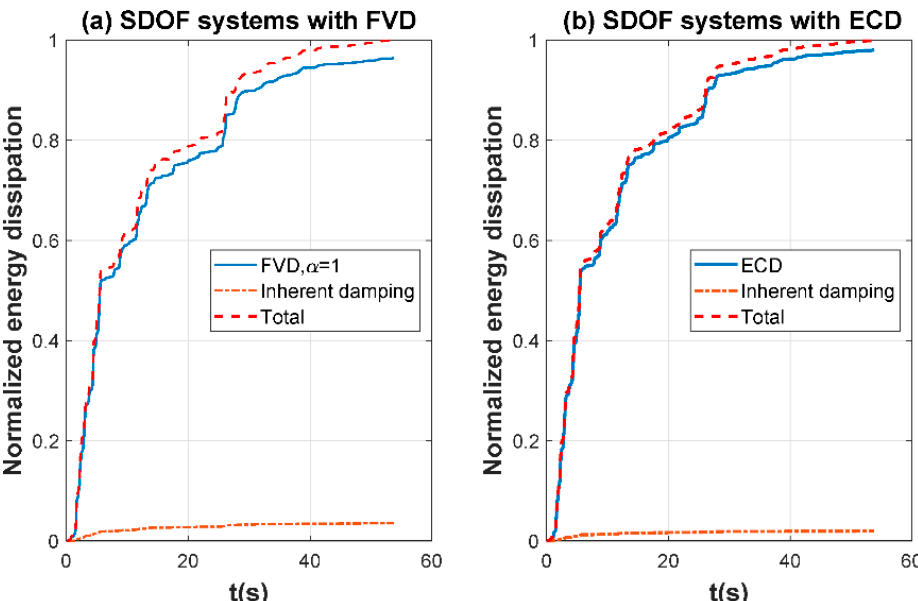
Figure 11. Dissipated energy of SDOF systems ( ζ = 2%) with FVD and ECD subjected to the Elcentro